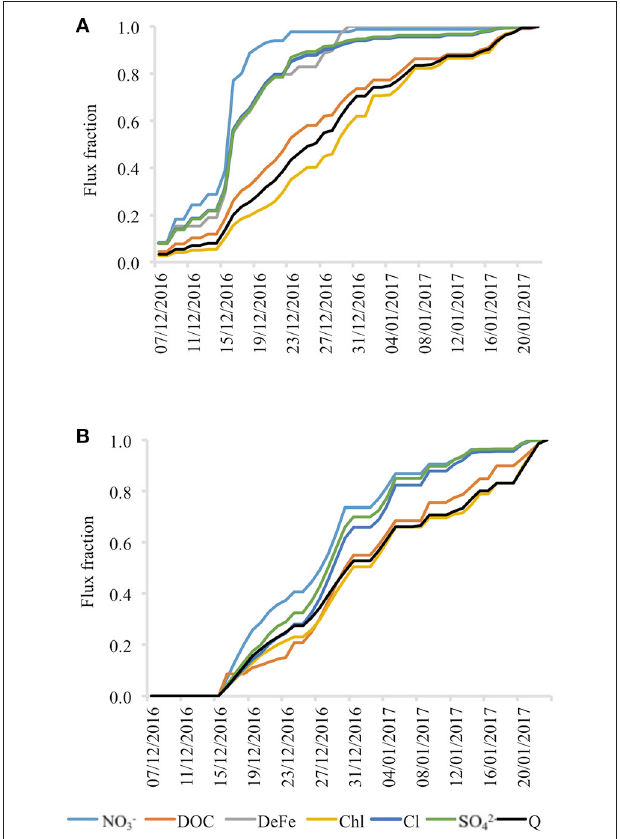
FIGURE 9 | Normalized flux of selected chemical species indicating differences in seasonal dynamics between monitoring sites. (A) Beach snowmelt and (B) Inland